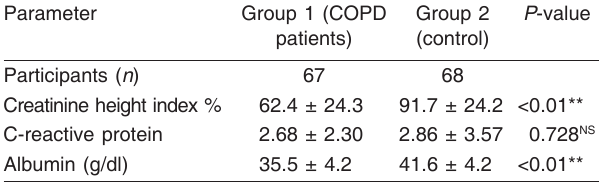
Table 3 Laboratory markers among the studied